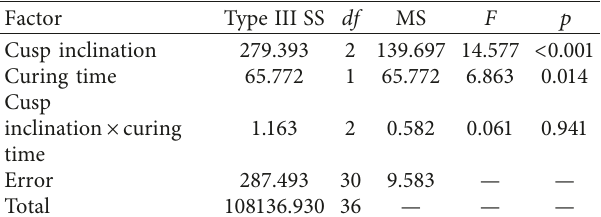
Table 5: Two-way ANOVA for the DC